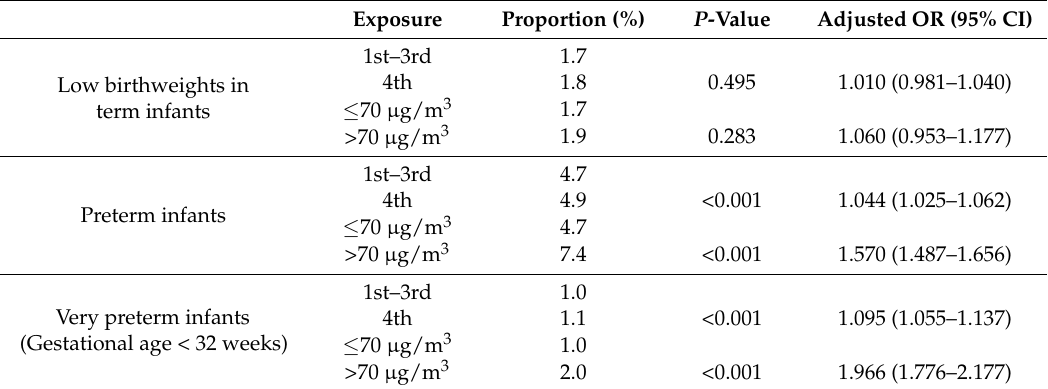
Table 3. Associations of low birth weight in term infants and preterm births with quartiles of particulate matter less than 10 µ m (PM 10 ) and the interim target-1 of WHO ( ≤ 70 µ g/m 3 ).